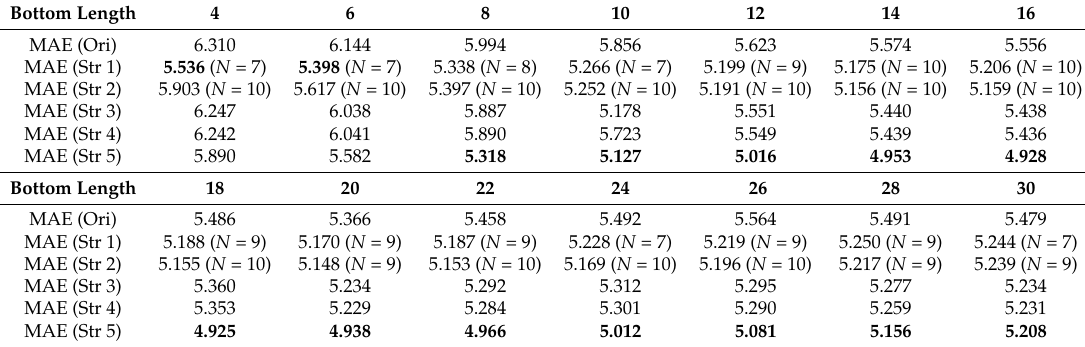
Figure 6. Different bottom lengths when generating the triangle age label distribution for the chronological age a . ( a ) bottom length of 4; ( b ) bottom length of 6; ( c ) bottom length of 8. Table 7. MAEs of the compared original LDL algorithm without decision-making strategy and the proposed SDM-LDL algorithms with different strategies on the condition that age label distribution are generated as triangle (bottom lengths from 4 to 30; for Strategies 1 and 2, best results are shown in the table along with the value of N then; for every bottom length, the optimal MAEs are marked in bold). Bottom Length